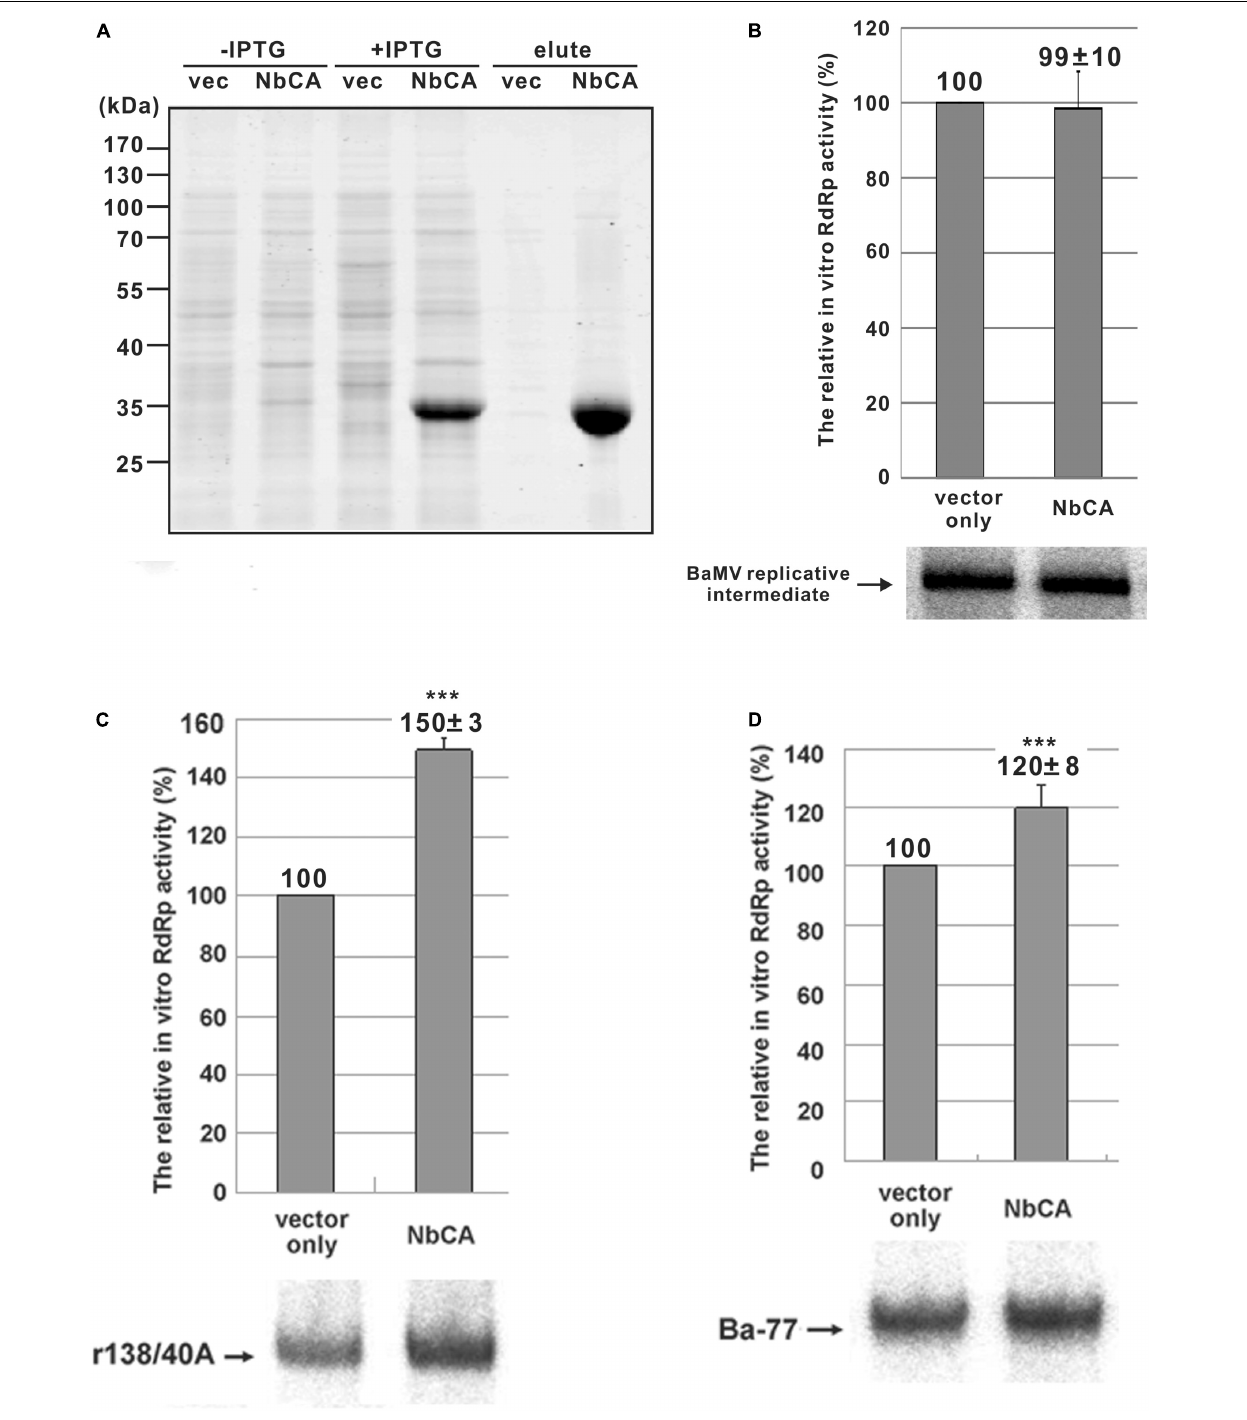
FIGURE 5 | The expression of NbCA in Escherichia coli and in vitro replication assays with endogenous and exogenous templates. (A) Total proteins were extracted from E. coli that expressed vector only (vec) or NbCA with or without the induction of IPTG as indicated, separated on a 12% polyacrylamide gel/SDS, and stained with Coomassie blue. The eluents indicated as elute were the total proteins eluted from His-tag purification resin. In vitro replication assay involved use of the purified replicase complex from infected plants with the addition of E. coli -expressed proteins (A) to test the RdRp activity of the endogenous templates (B) and exogenous templates r138/40A (C) and Ba-77 (D) . RdRp activity with the addition of E. coli -expressed eluent of vector only was set to 100%. Representative results are shown. The numbers shown above each bar are the mean relative RdRp activity with the standard errors derived from at least three independent experiments. ∗∗∗ p < 0.001 by Student’s t